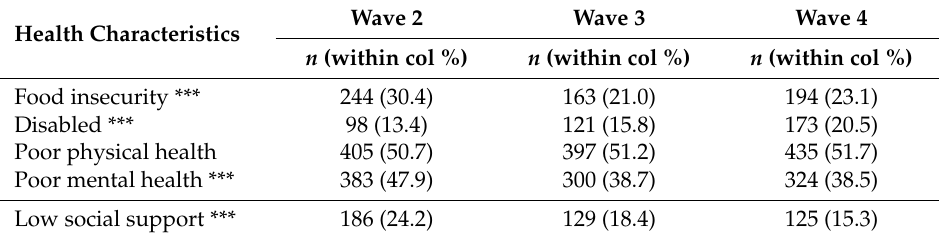
Table 2. Sample Health Characteristics and significance of change over time ˆ.